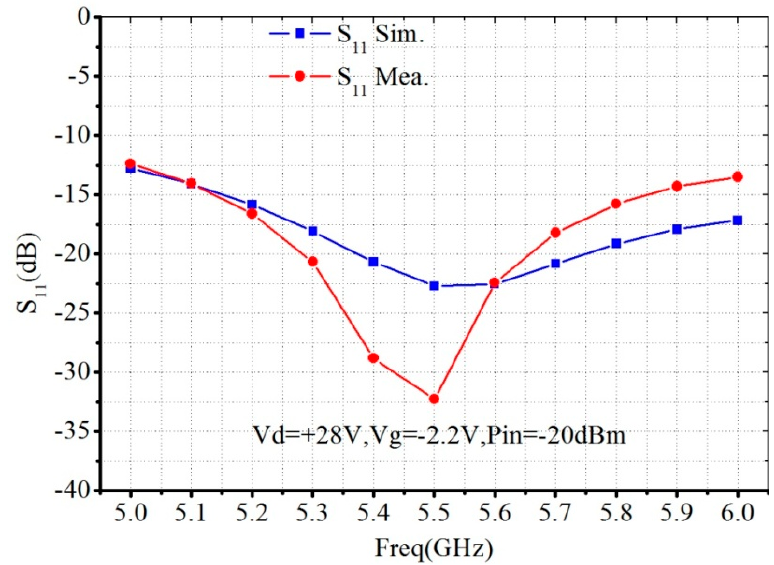
Figure 6. Simulated and measured S 11 of the proposed C-band 30 W PA